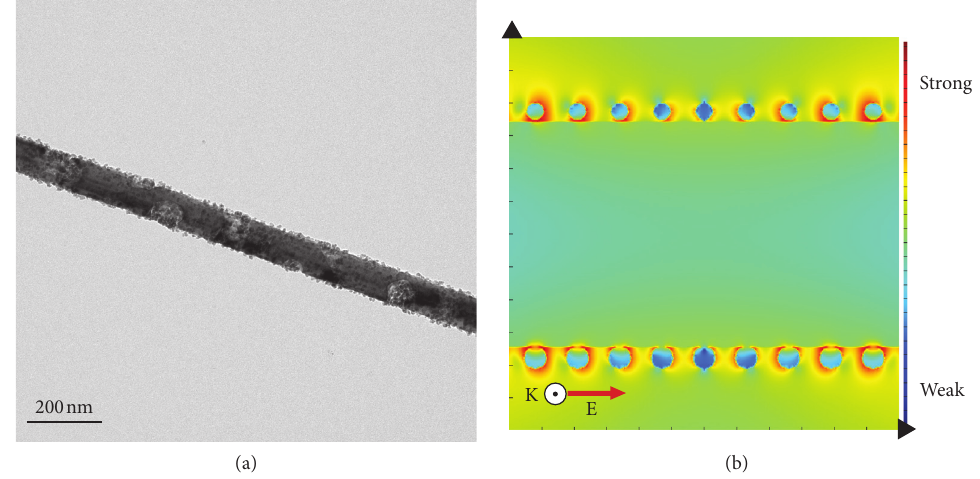
Figure 3: The electric field intensity distribution simulation of local electric field distribution for AgNW@AuNPs in the X - Z plane with 785nm incident light. TEM images of AgNW@AuNPs (a) and its corresponding simulated electric field intensity distribution images